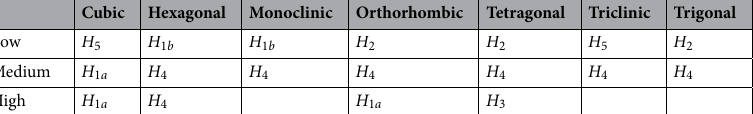
3 3 3 ≤ ρ ≤ ), medium (4 g/cm 9 g/cm ) and high density ( ρ > 9 g/